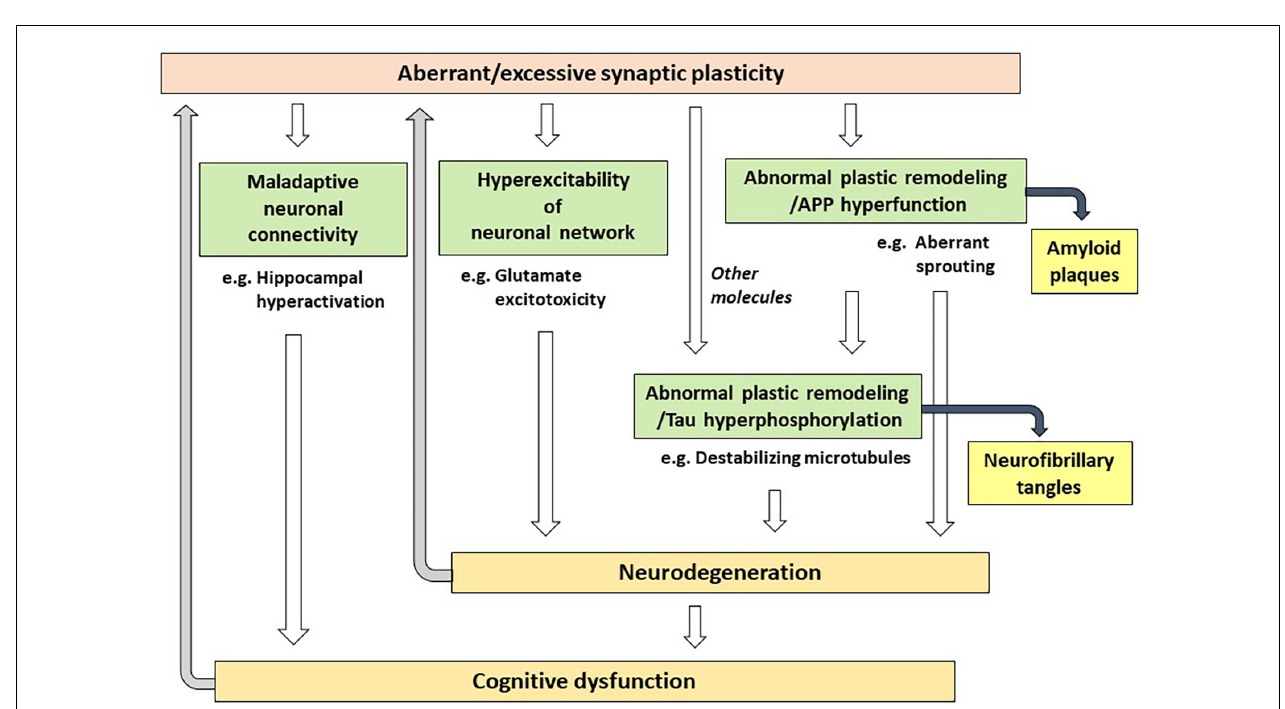
FIGURE 2 | Possible mechanisms of how aberrant/excessive plasticity causes cognitive dysfunction in Alzheimer’s disease.